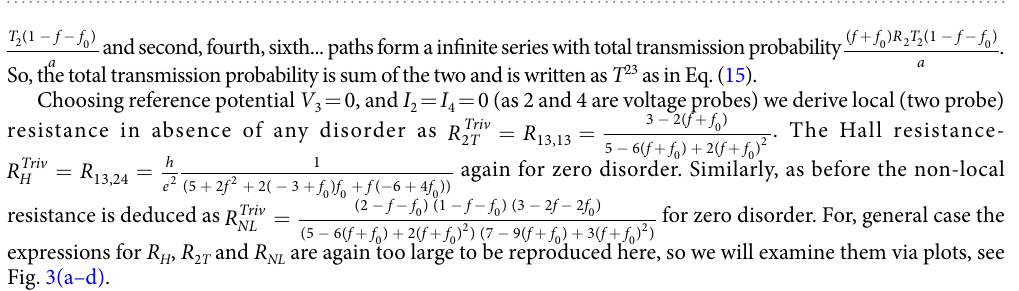
expressions for R H , R 2 T and R NL are again too large to be reproduced here, so we will examine them via plots, see Fig. 3(a–d).